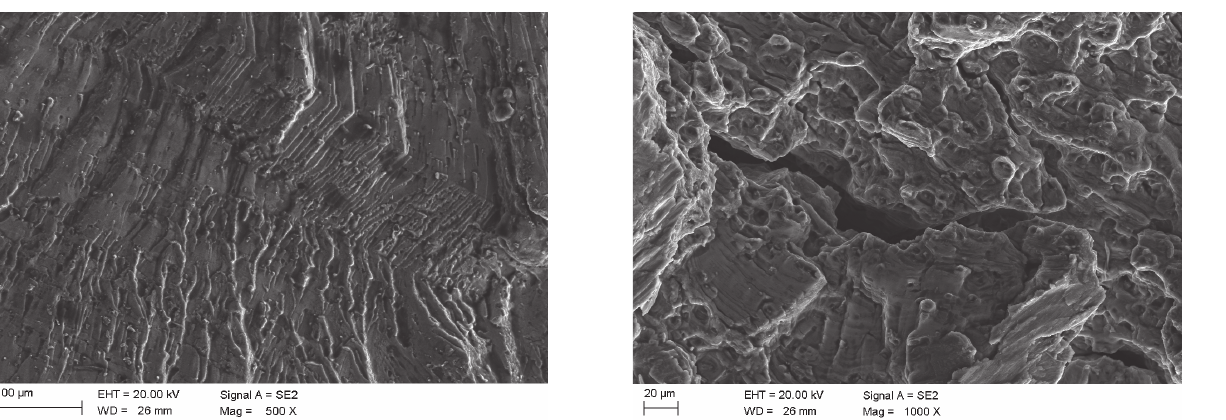
Figure 7: Transcrystalline quasi-cleavage fracture with flat and smooth surfaces of the AlZn6Mg0.8Zr alloy